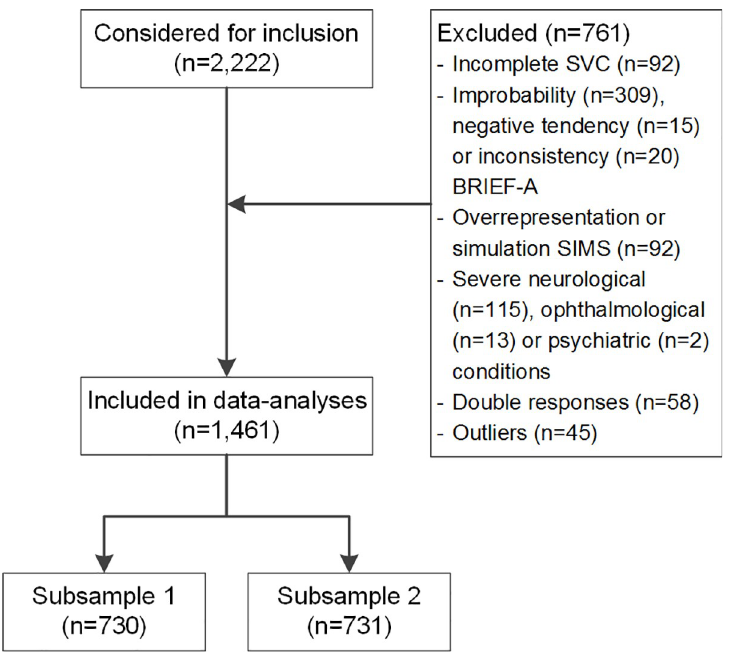
Fig 1. Flowchart of inclusion. SVC, Screening of Visual Complaints questionnaire; BRIEF-A, Behavior Rating Inventory of Executive Function-Adults; SIMS, Structured Inventory for Malingered Symptomatology.